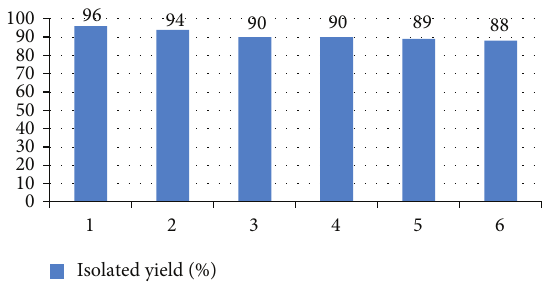
Figure 5: Reusability of sulfonic acid functionalized nano- 𝛾 -Al 2 O 3 synthesis of 3-phenyl-2 H